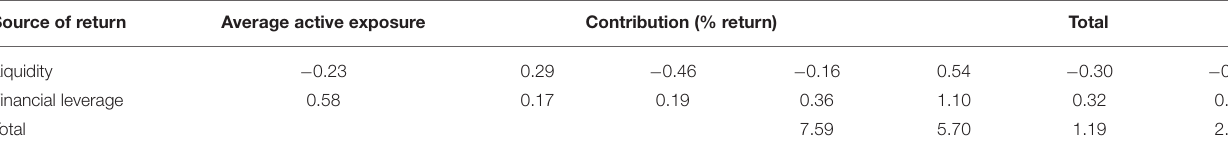
TABLE 4 | Robust regression with the Beaton-Tukey WLRR